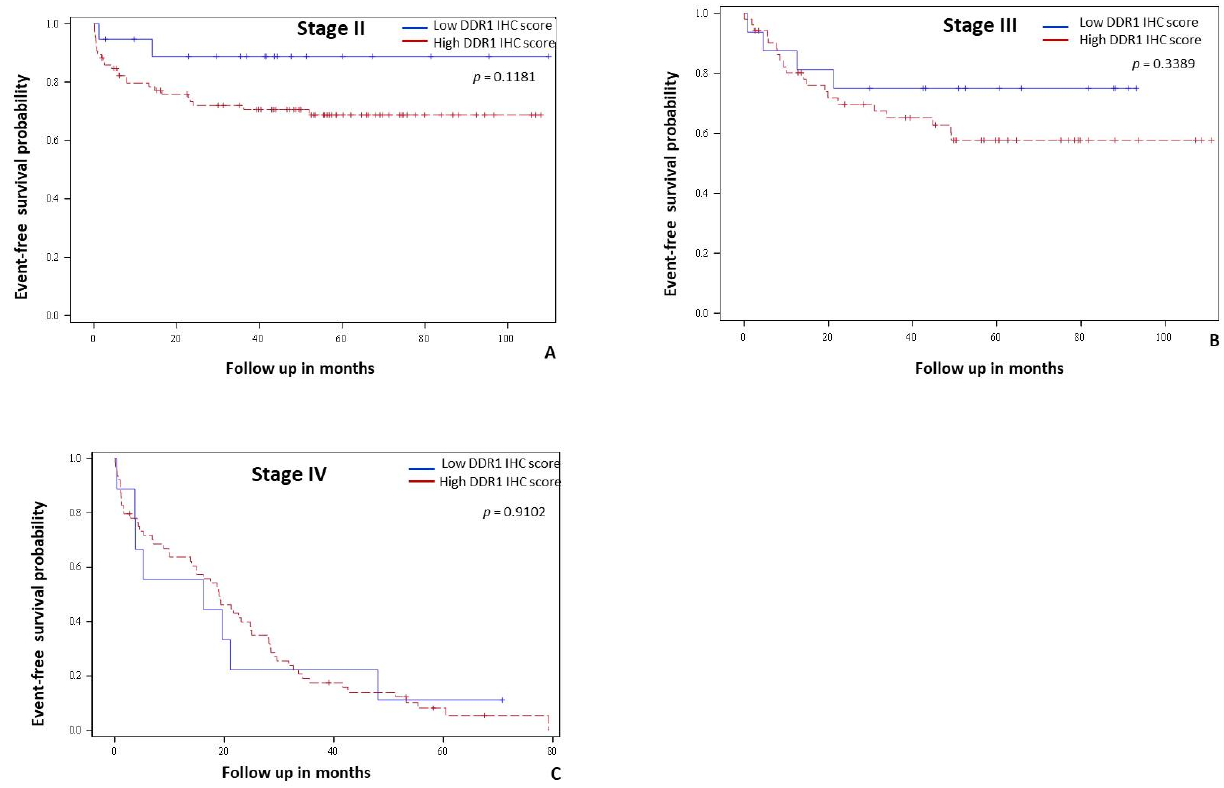
Figure 3. Stage specific event free survival analysis in colon cancer patients from our cohort according to DDR1 immunohistochemical expression. Kaplan-Meier curves of event free-survival probability for low (blue line) and high (red line) DDR1 immunohistochemical expression in cells in stage II ( A ), stage III ( B ) and stage IV patients ( C ).